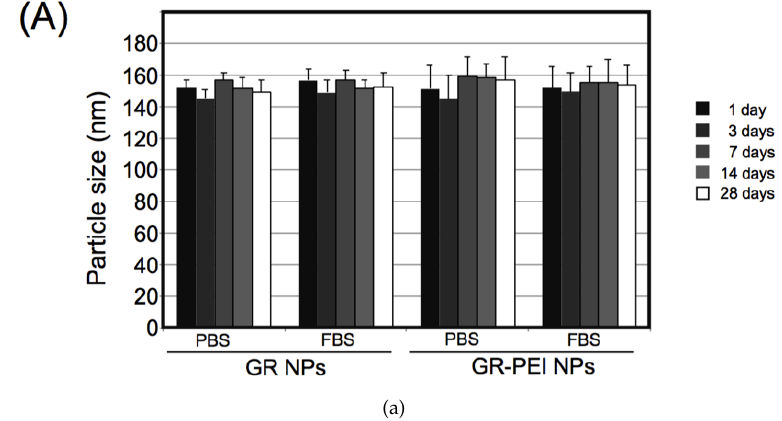
Table 1. Physical properties of nanoparticles.